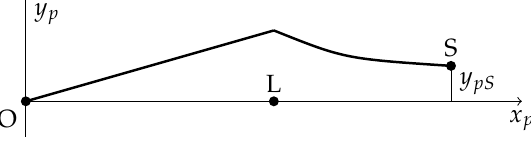
Figure 5. A cosmologically bent ray, bent back. The